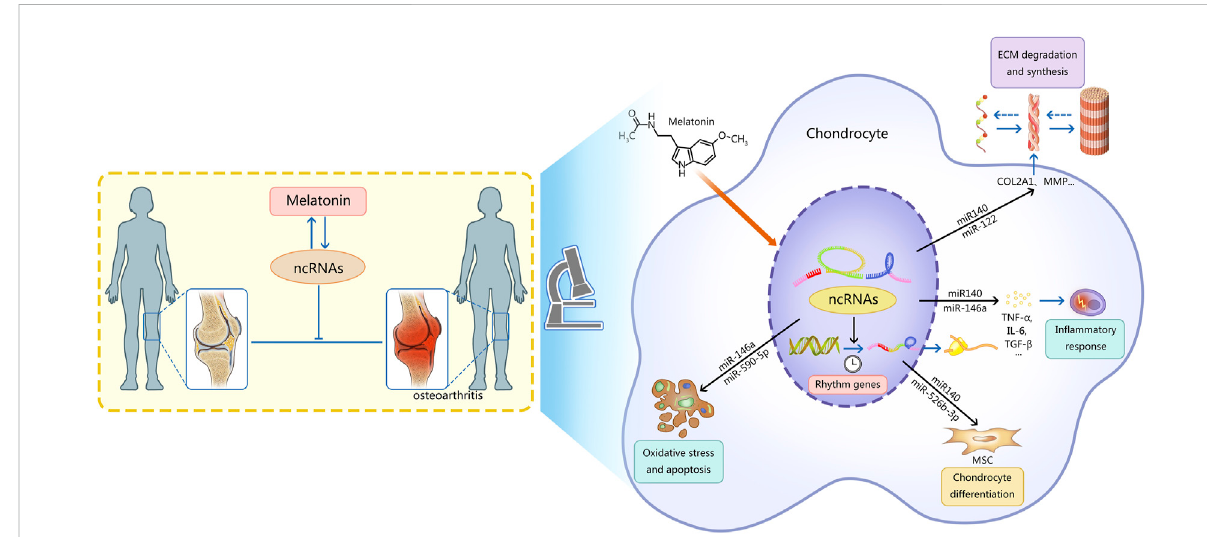
FIGURE 1 This fi gure describes the mechanism of interaction between ncRNAs and melatonin in osteoarthritis. Note: Melatonin can regulate OA by regulating the level of ncRNAs, which is mainly re fl ected in fi ve aspects: 1) regulating the degradation and synthesis of the chondrocyte matrix; 2) regulating the oxidative stress and apoptosis of chondrocytes; 3) regulating the differentiation of chondrocytes; 4) regulating rhythm genes; 5) regulating in fl ammatory mediators.Ultimately the progression of osteoarthritis is delayed. Meanwhile, ncRNAs can regulate the synthesis and function of melatonin. AANAT, arylalkylamine N-acetyltransferase; ncRNAs, non-coding RNAs; MSC, mesenchymal stem cells; MMP, matrix metalloproteinase; ADAMTS, a disintegrin metalloproteinase with thrombospondin motifs; ECM, extracellular matrix; TNF- α , tumor necrosis